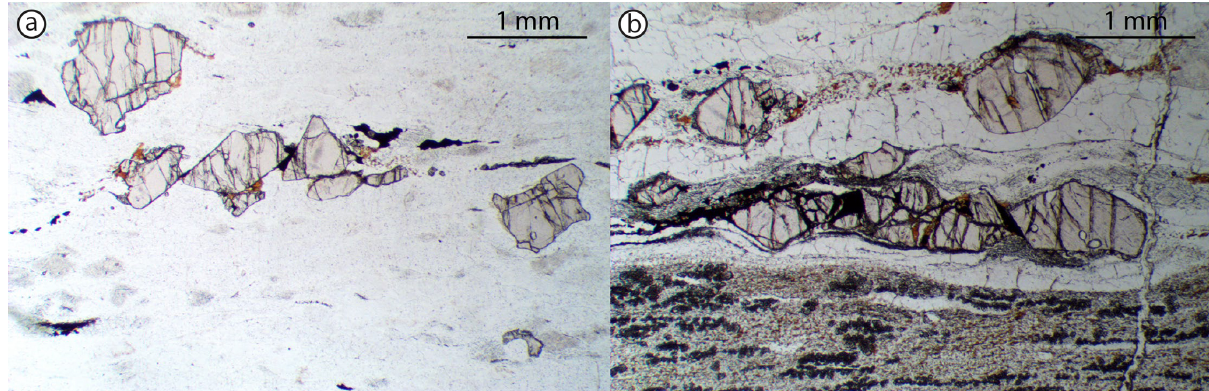
Figure 3. Thin-section photomicrographs in plane-polarized light of fractured garnets (a) away from pseudotachylyte and (b) close to sheared and recrystallized pseudotachylyte in the lower part of the image. The dark trails of grains elongated in the foliation of the sheared pseudotachylyte are small new garnets. The section is perpendicular to the foliation and parallel to the stretching